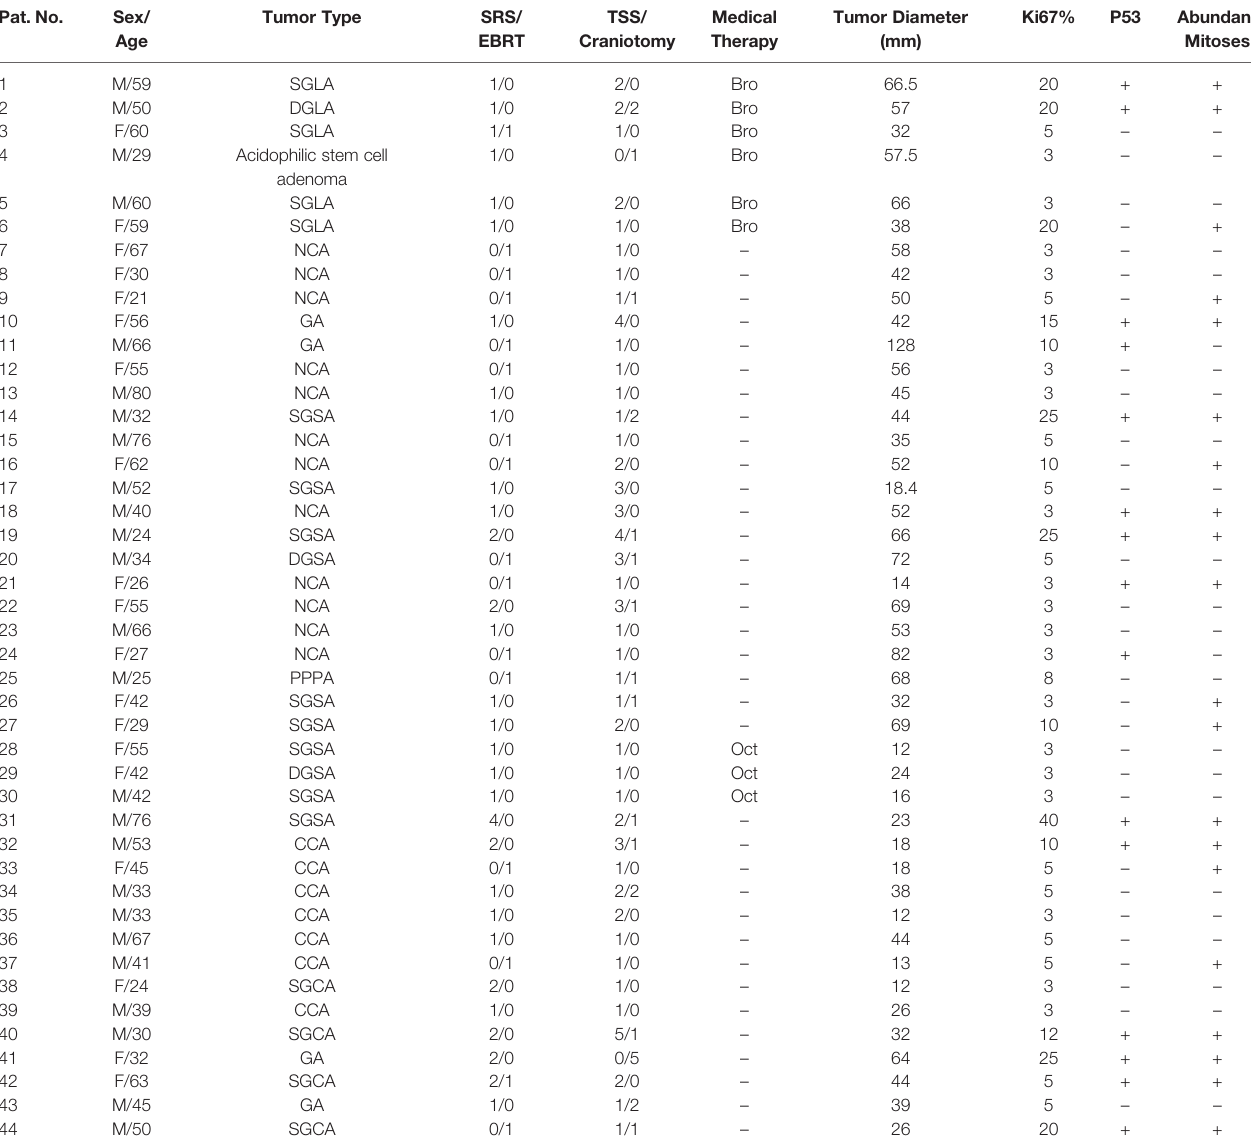
TABLE 1 | Clinical and immunohistochemical characteristics of the 44 refractory PAs. Pat.